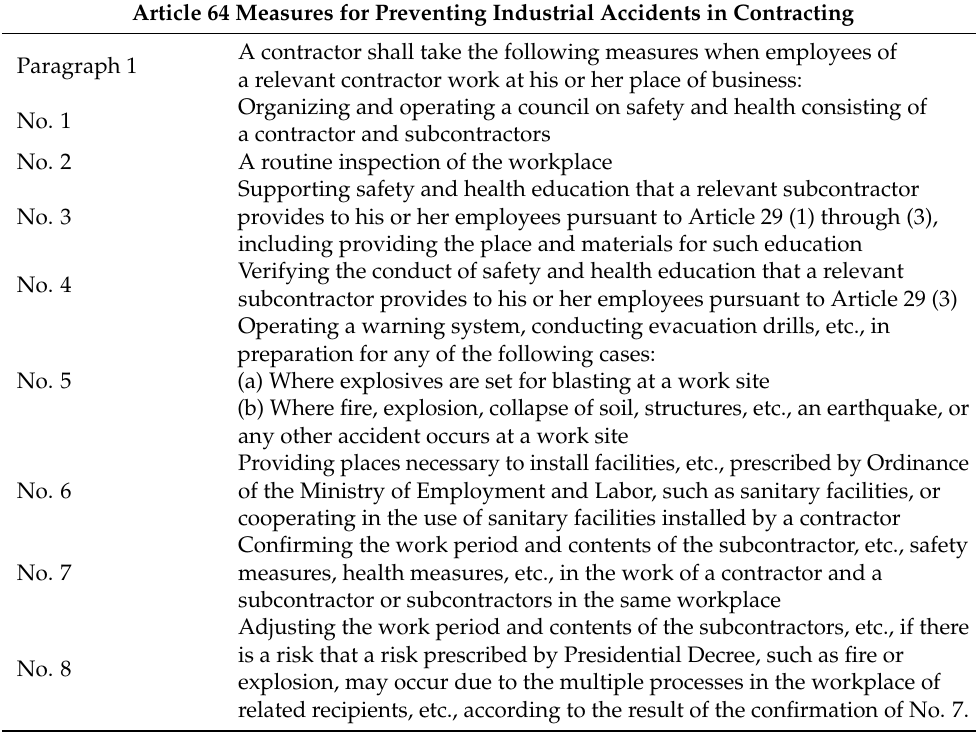
Table 1. Occupational Safety and Health Act Article 64, Paragraph 18 (in Korea). Article 64 Measures for Preventing Industrial Accidents in